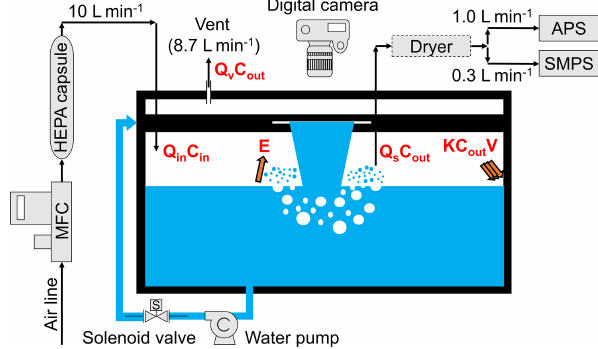
Figure 1. A schematic of the experimental setup used in this